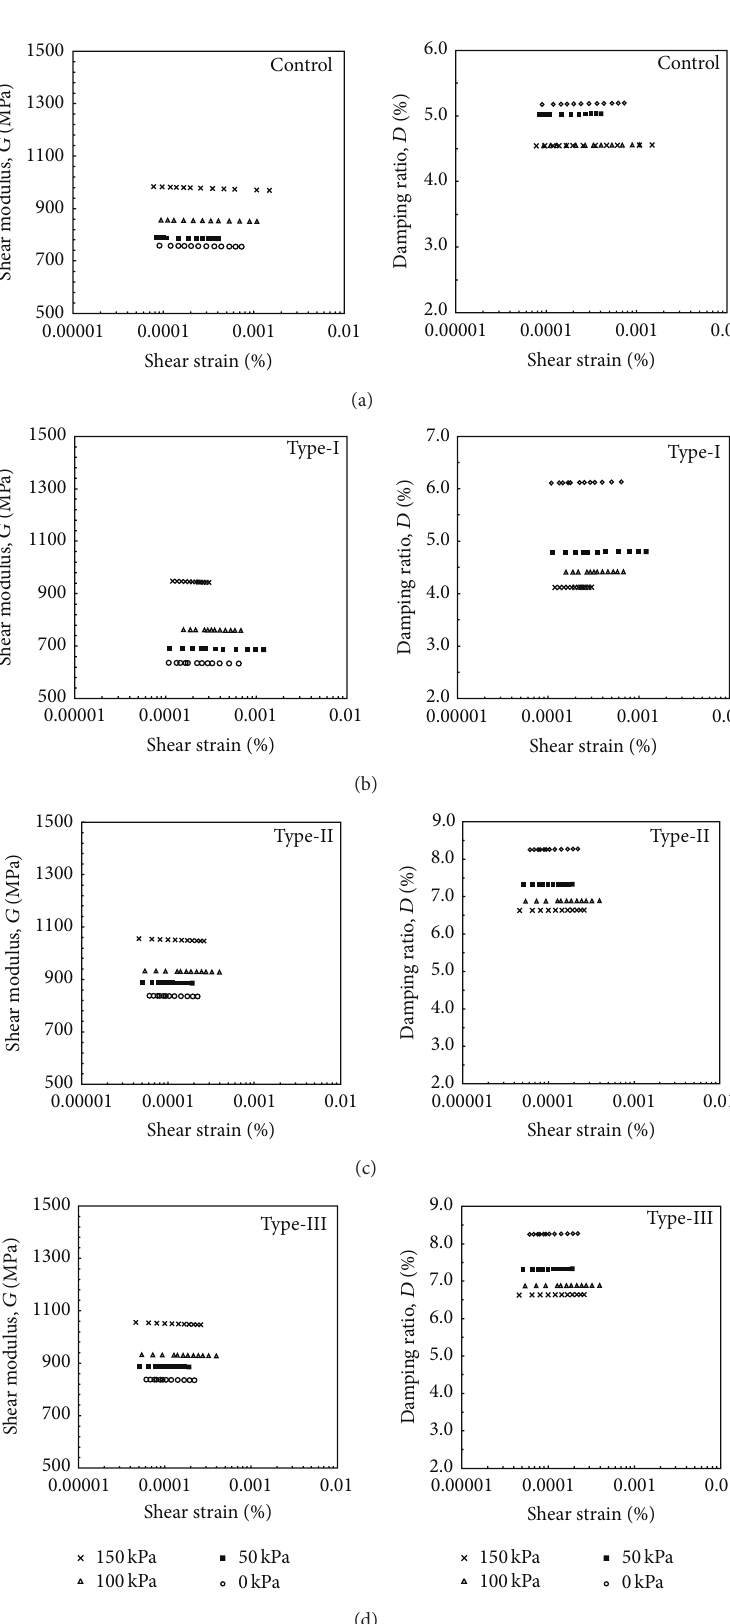
Figure 11: Effect of confinig stress and rubber type on shear modulus and damping ratio: (a) Control samples (b) Type-I, (c) Type-II, and (d)